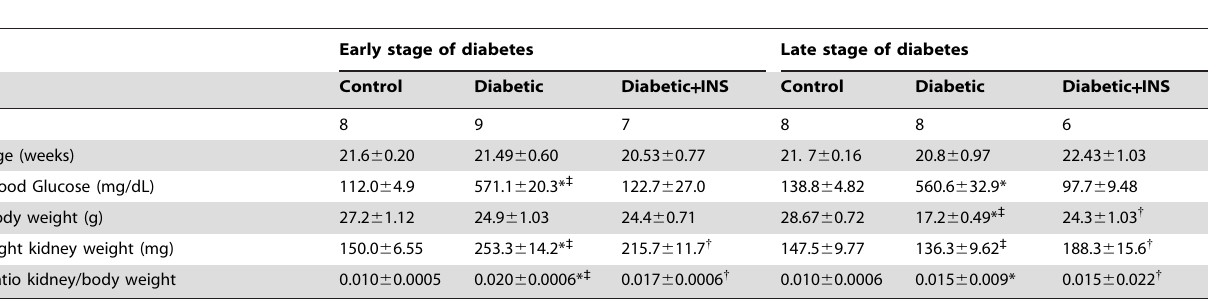
Table 1. Animal characteristics for NOD diabetic mice (Diabetic), NOD diabetic mice treated with insulin (Diabetic + INS) and NOR control mice